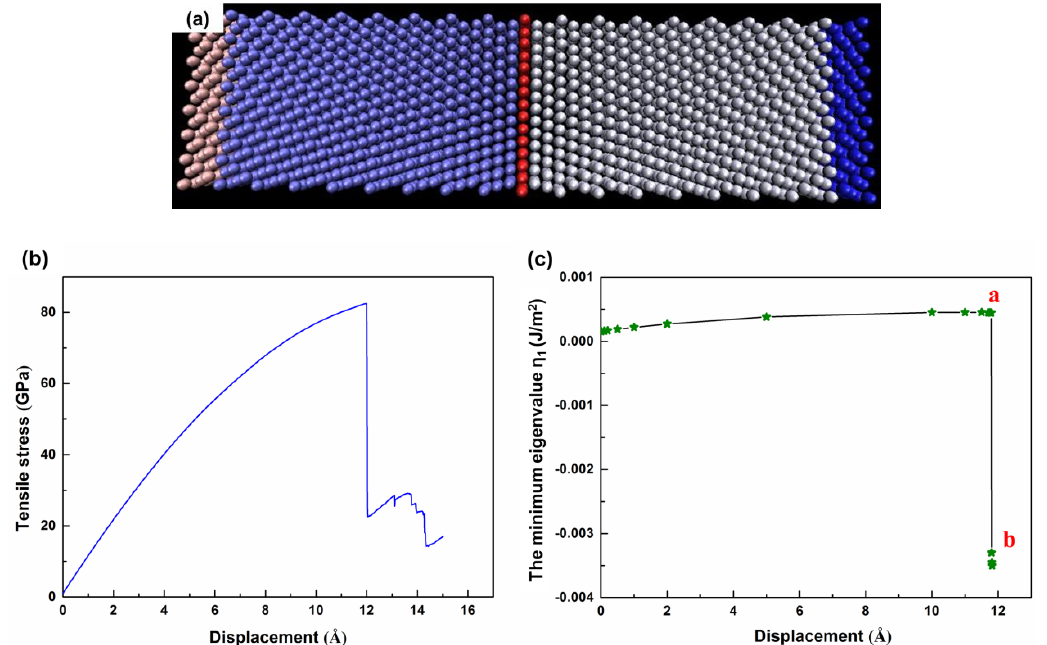
Figure 6. ( a ) Atomic structure of the bicrystalline model A with a coherent twin boundary. ( b ) Plot of tensile stress vs. displacement. ( c ) Plot of the calculated minimum eigenvalue ( η 1 ) of matrix A vs. displacement.